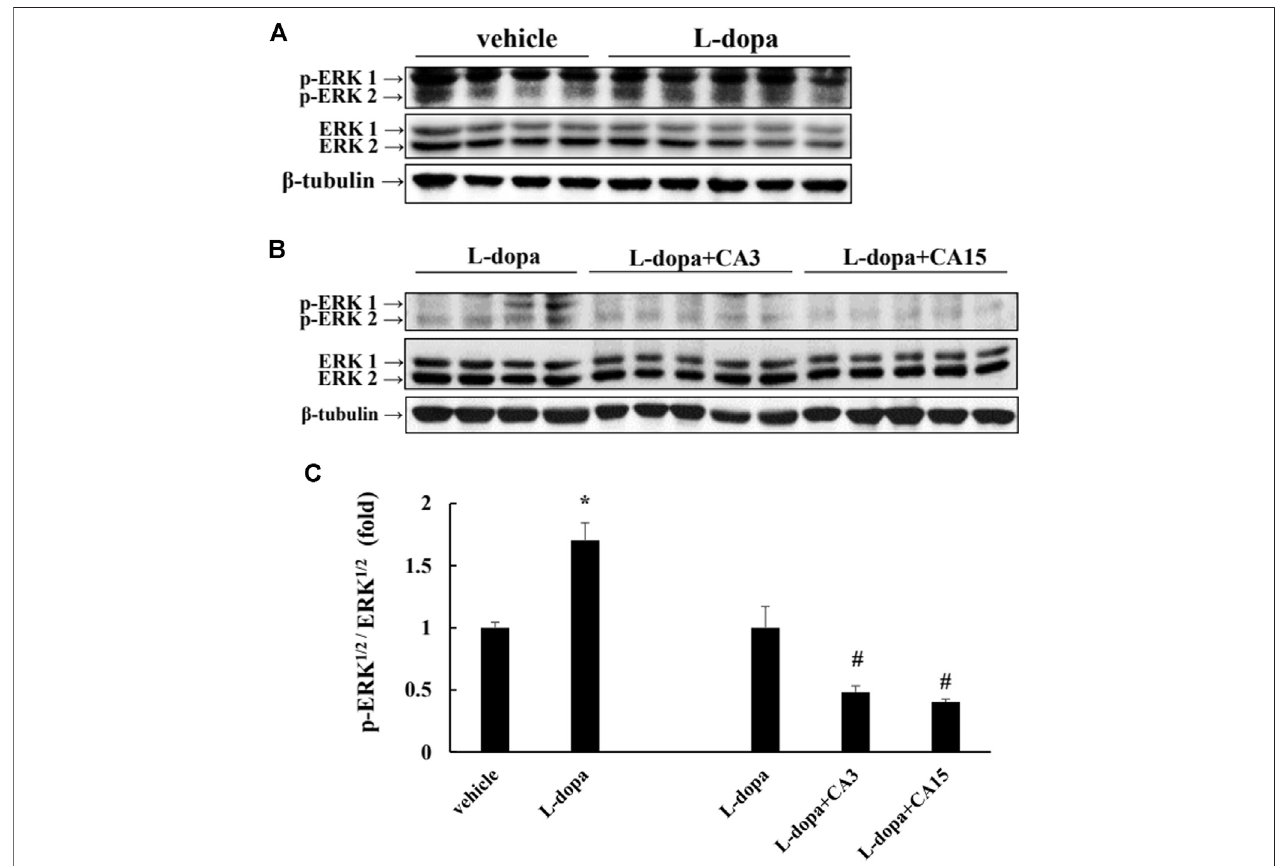
FIGURE3| EffectofCAon L -dopa-inducedactivationofERK1/2andc-Junin6-OHDAlesionedrats.ThephosphorylationofERK1/2 (A,B) instriatumtissueswere determined by Western blotting. β -Tubulin was used as the internal control. (C) The level of the L -dopa group was set at 1.0. Values are mean ± SEM ( n (cid:1) 3). # p < 0.05 compared with L -dopa-treated